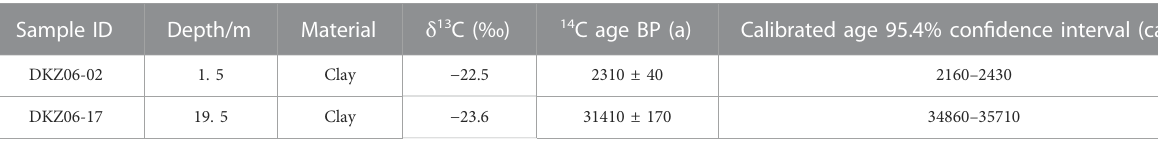
TABLE 2 Sample data and 14 C age results for two samples from core DKZ06. Sample